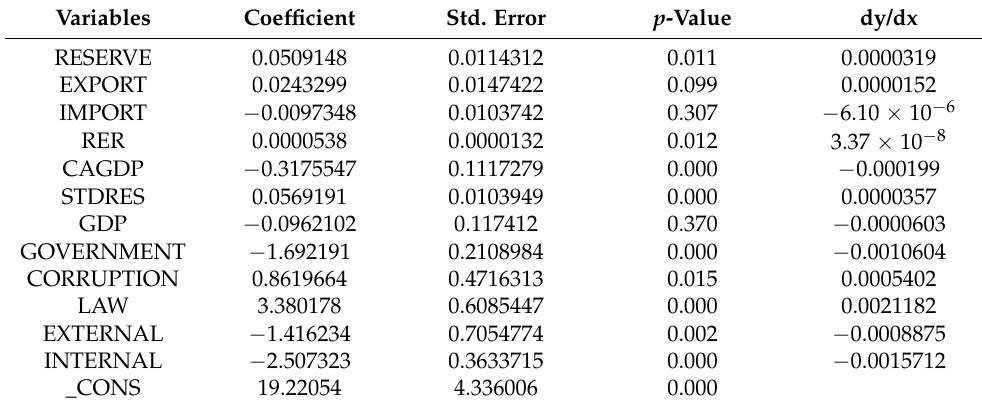
Table 10. Results of EWS model in Latin American